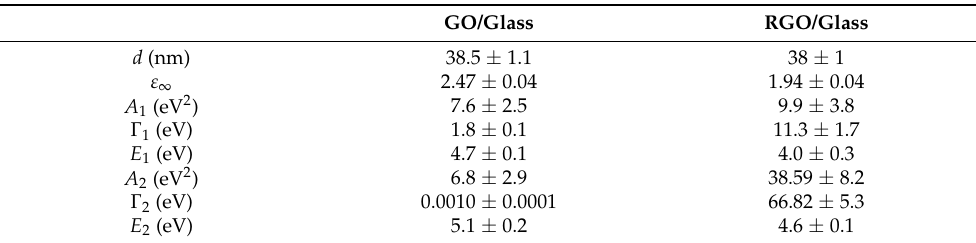
Table 1. Lorenz oscillators parameters for GO and RGO films on glass substrates. Amplitude A k has unit of eV 2 , center energy E k and broadening Γ k have units of eV, d is the thickness of film in nm, the frequency dielectric constant ε ∞ is dimensionless.